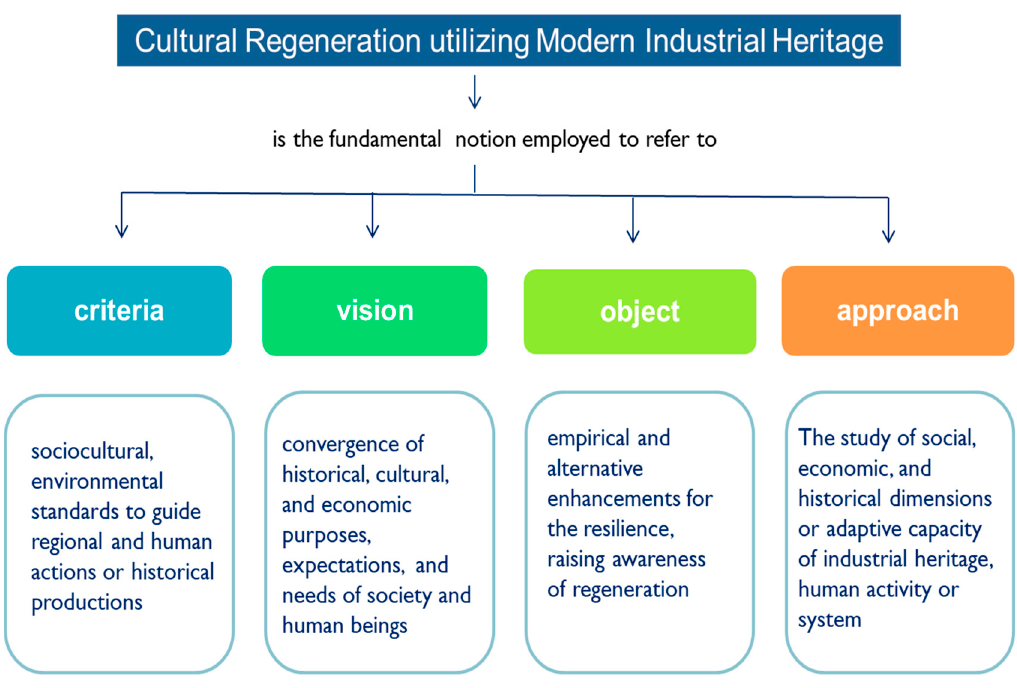
Figure 9. Processes and results of cultural regeneration utilizing modern industrial heritage.